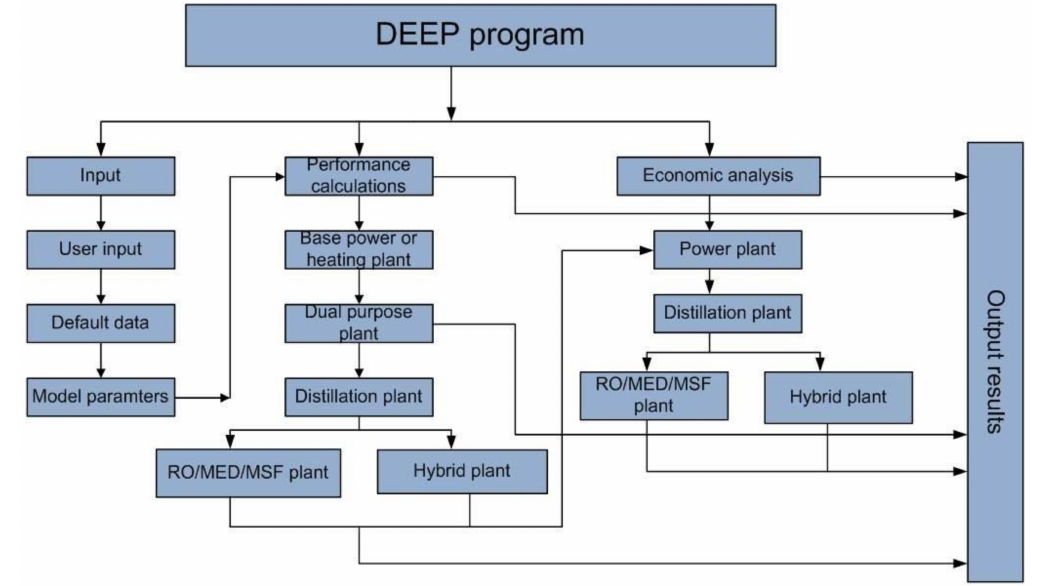
Figure 6. Working mechanism of DEEP.